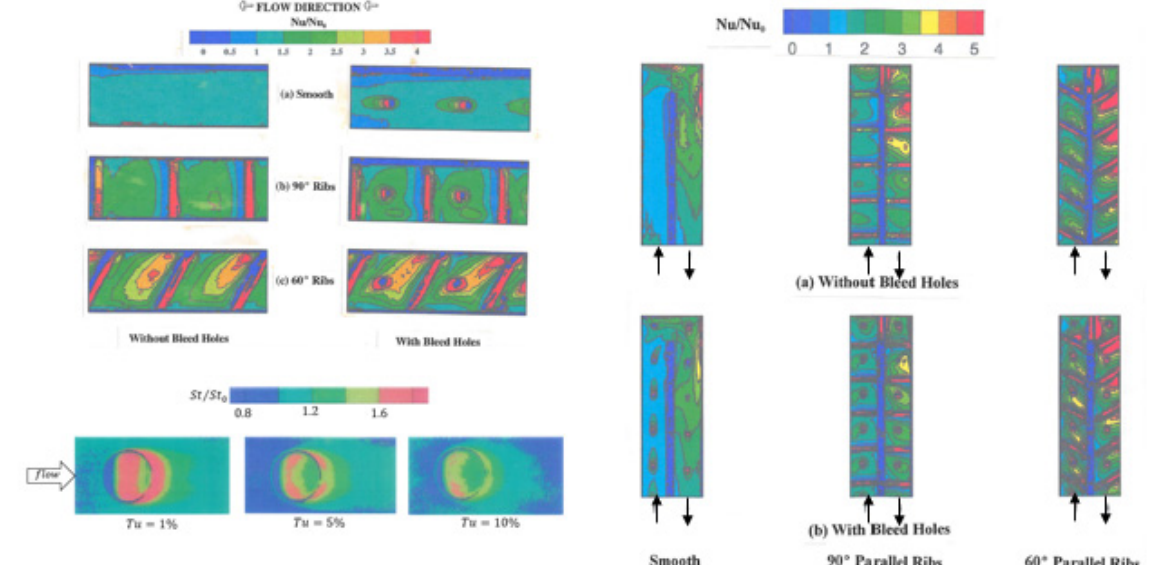
Figure 3. Detailed map of the normalized convective heat transfer coefficient h (W/m 2 K) in the form of Nu and St in rib turbulators/dimple-based cooling configurations [21] (original figures contributed by the 1st author, Ekkad, S.V.).